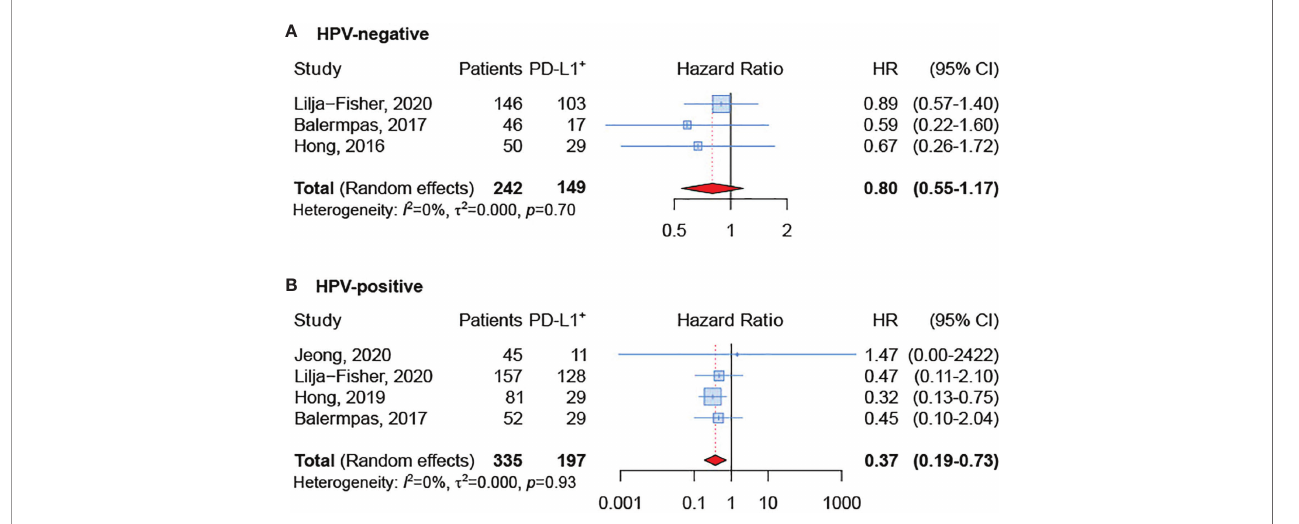
FIGURE 3 | Forest plot for the association between PD-L1 expression and overall survival in HPV-negative (A) and HPV-positive (B) tumors.